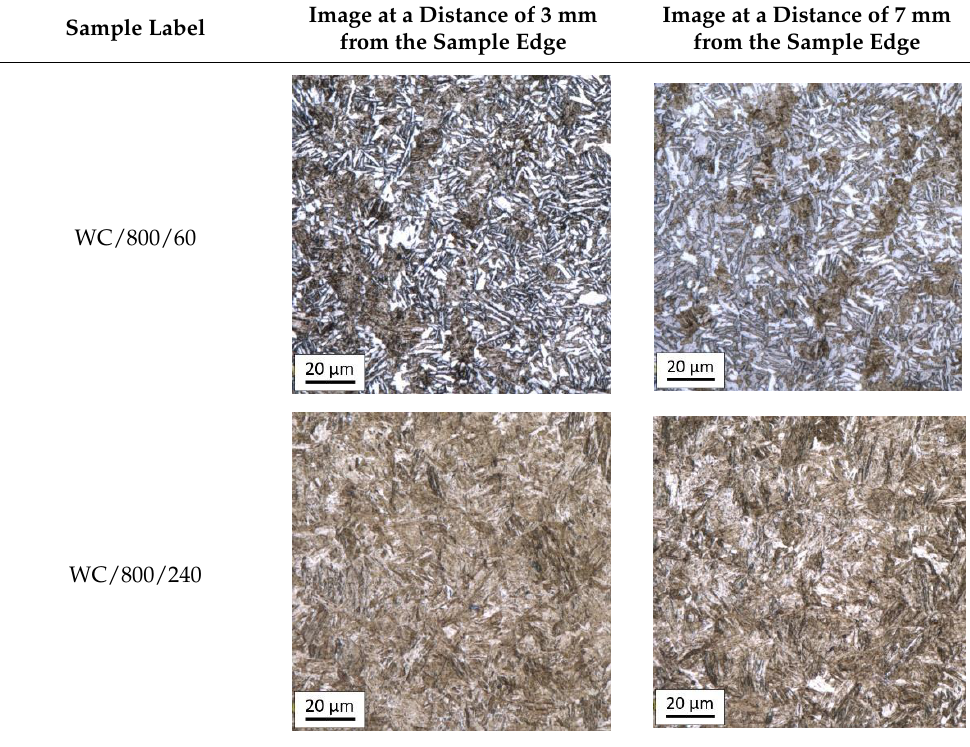
Table 7. Microstructure of steel after heating at 800 °C for 60 min and 240 min with water cooling. Sample Label